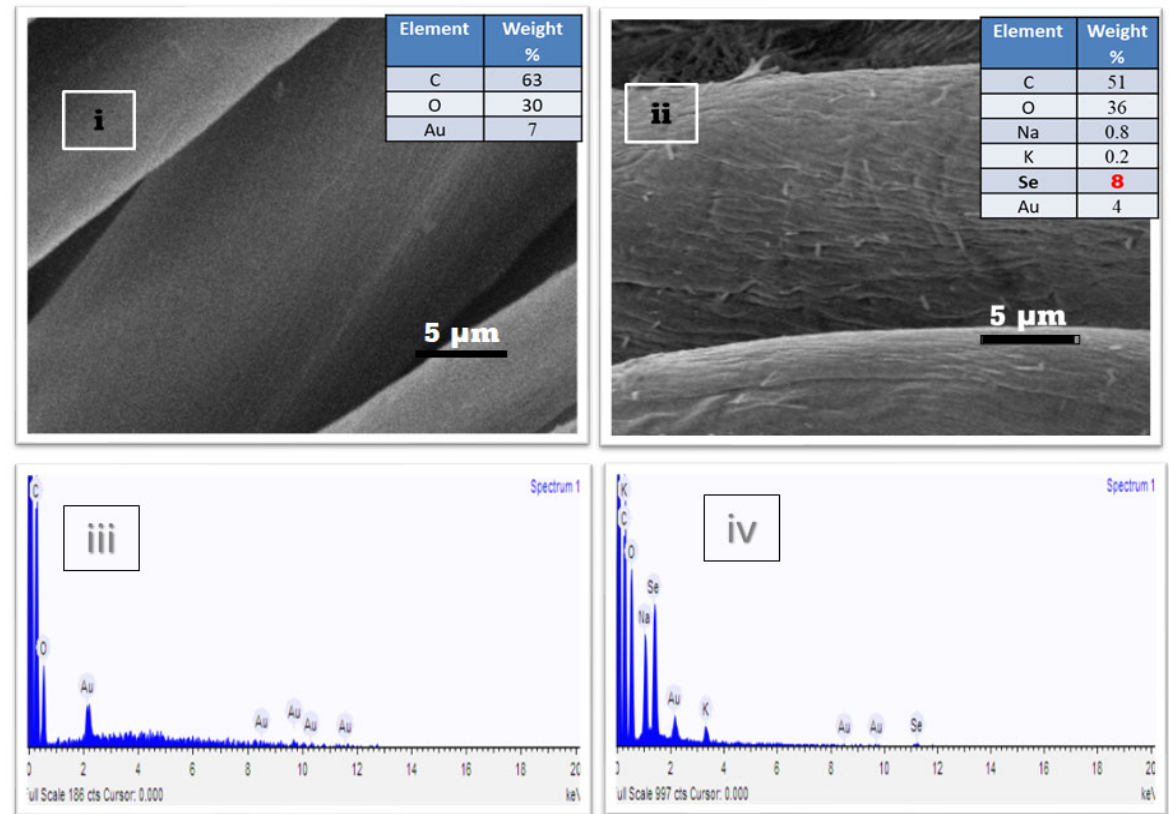
Figure 8. Scanning Electron Microscope and EDX spectra of Uncoated fabric ( i , iii ) and Se-coated-30 ( ii , iv ). The scale bar is 5 μ m.